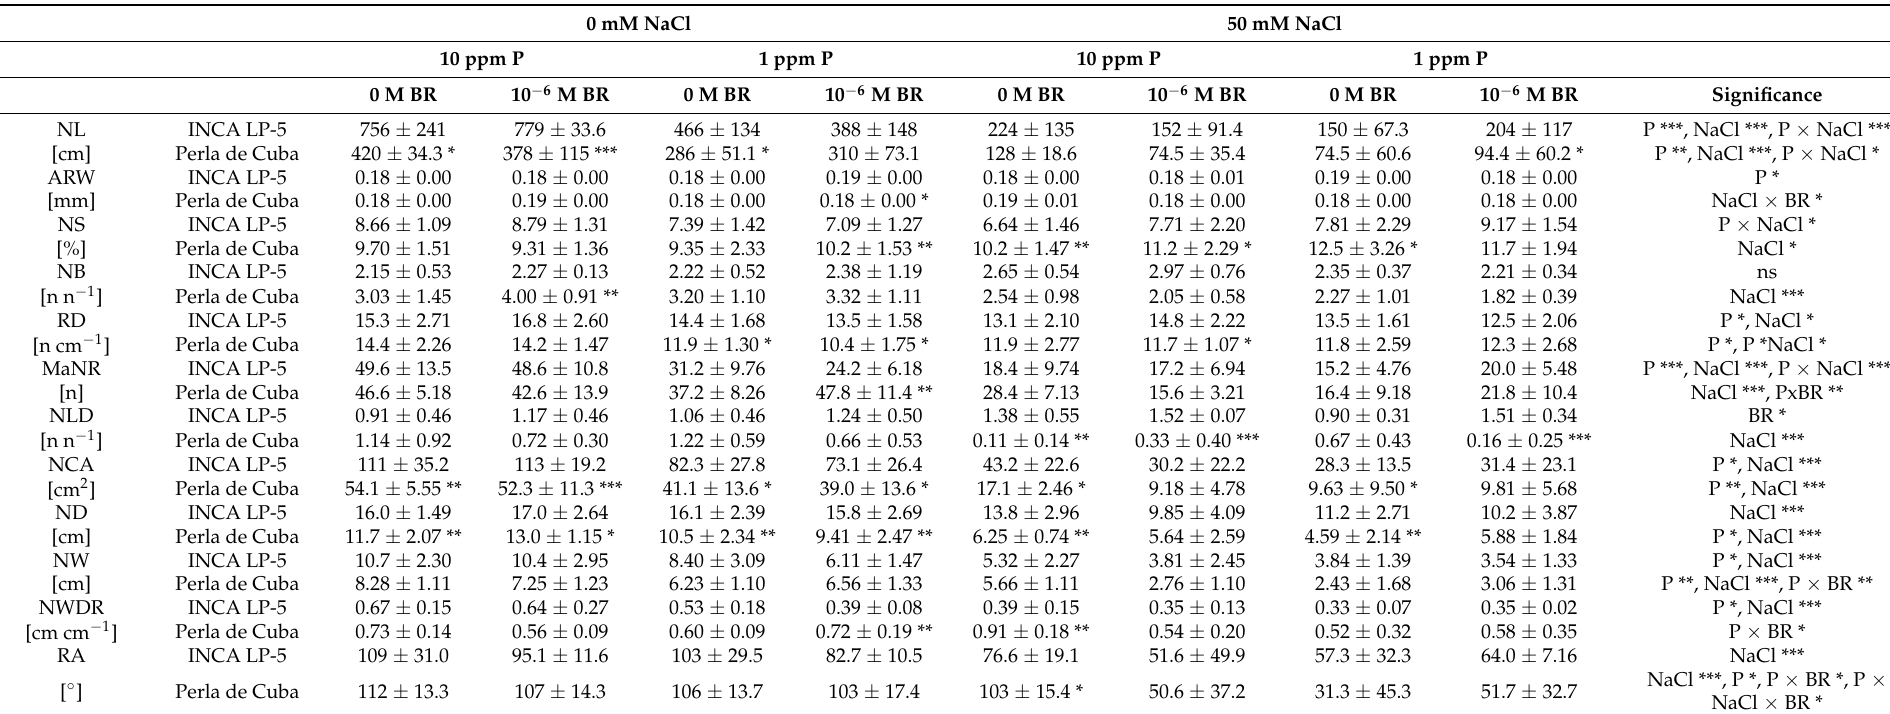
Table 3. Selected root-system traits of the two rice genotypes INCA LP-5 and Perla de Cuba after three weeks of growth in mini-rhizotrons (mean ± SD). Significant differences between treatments of phosphorus (P), salt (NaCl), 24-epibrassinolide (BR) and their interactions after ANOVA are shown by asterisks ( p < 0.05 * 0.01 ** 0.001 ***) and given for both cultivars. Significant differences between cultivars in each treatment are indicated. NL: network length; ARW: average root width; NS: network solidity; NB: network bushiness; RD: lateral root density; MaNR: maximum number of roots; NLD: network length distribution; NCA: network convex area; ND: network depth; NW: network width; NWDR: network width-to-depth ratio; RA: root